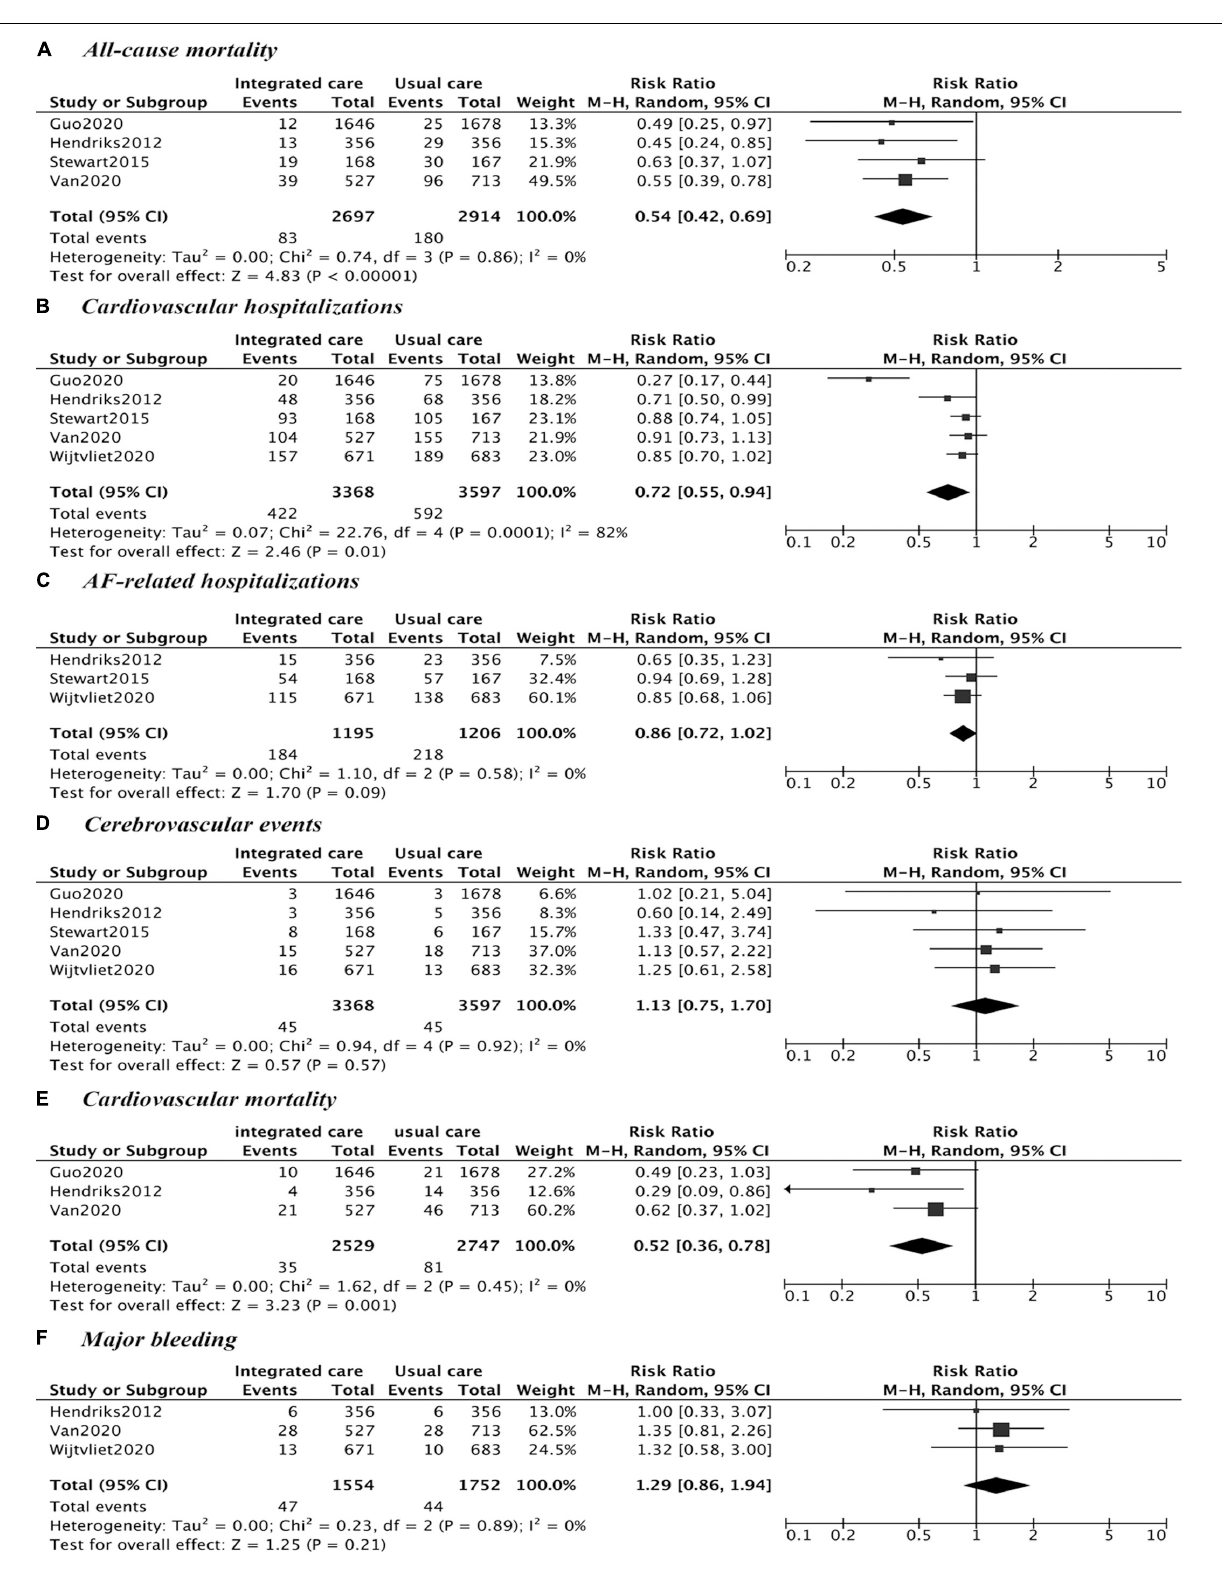
FIGURE 2 | Comparison of integrated care and usual care. (A) All-cause mortality; (B) cardiovascular hospitalizations; (C) AF-related hospitalizations; (D) cerebrovascular events; (E) cardiovascular mortality; (F) major bleeding.